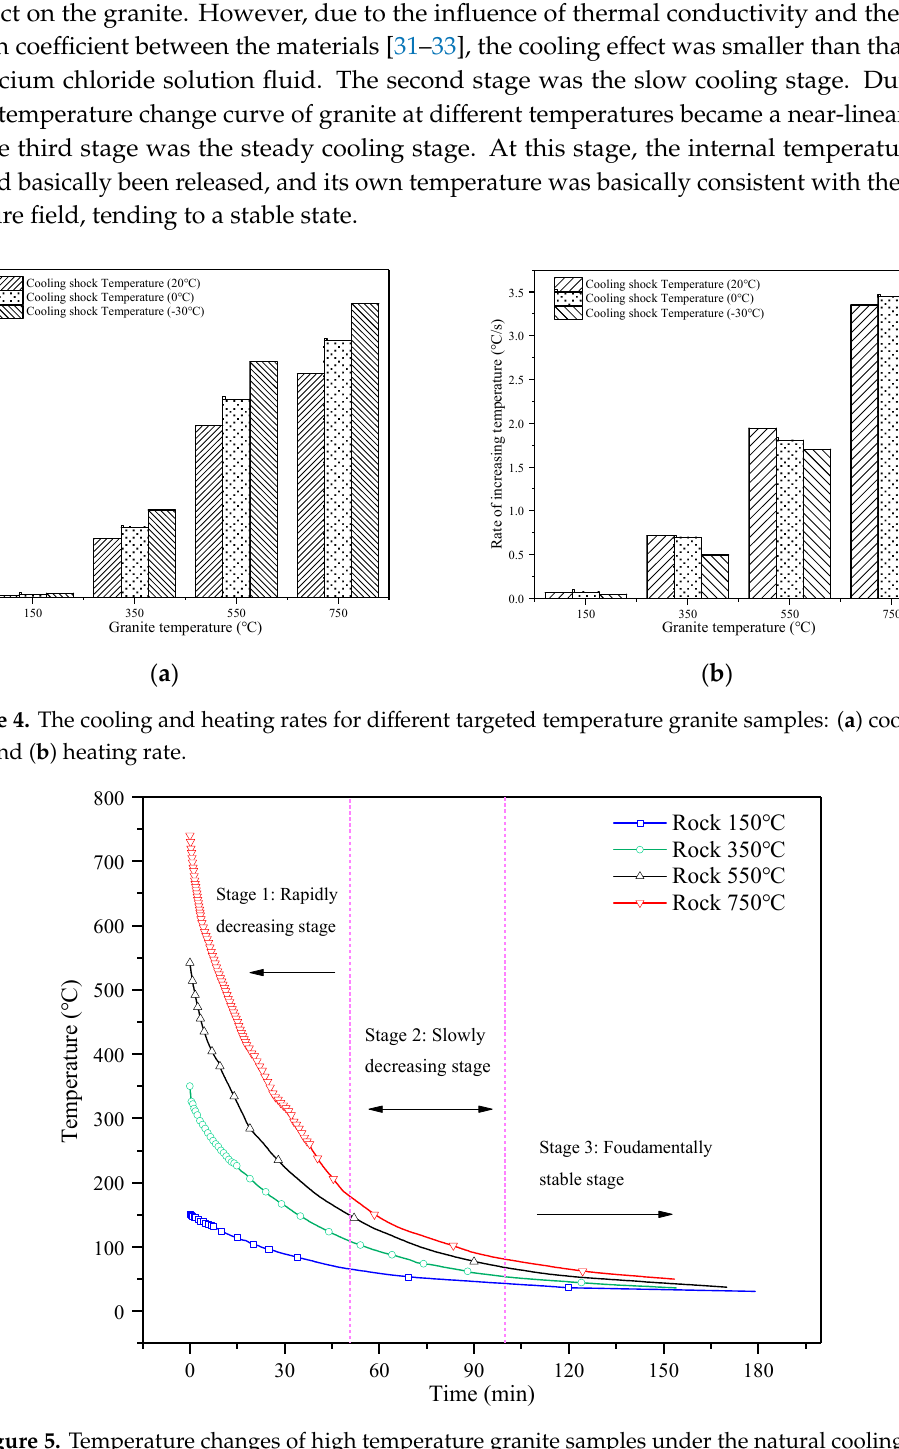
Figure 5. Temperature changes of high temperature granite samples under the natural cooling.